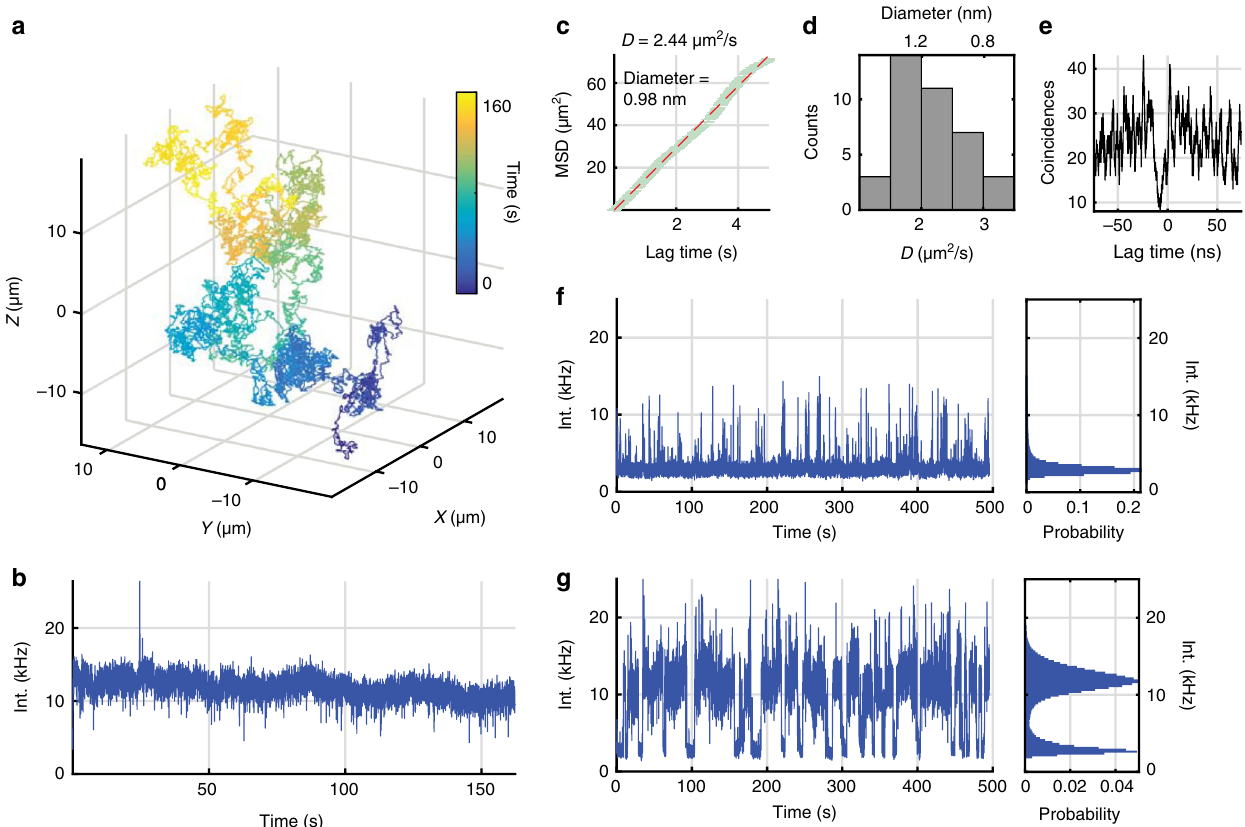
Fig. 2 Locking on to single fl uorophores with 3D-SMART. a 3D trajectory of a single Atto 647 N molecule tracked for 160 s in 90 wt% glycerol. XYZ coordinates are extracted from the readout of the pieozelectric nanopositioner during active feedback. b Intensity trace recorded during the trajectory shown in ( a ), showing uniform intensity despite the rapid diffusion of the molecule. c MSD versus lag time and linear fi t of the trajectory in ( a ), yielding a hydrodynamic diameter of 0.98 nm, consistent with a single fl uorophore. d Histogram of diffusion coef fi cients and hydrodynamic diameters of a population of Atto 647 N trajectories (number of trajectories n = 38). e Photon-pair correlation trace for the molecule in Fig. S6a, showing anti-bunching of photon arrivals at short lag time. f , g Comparison of single-molecule data collection with feedback ( f ) off and ( g ) on. Histograms demonstrate the increase in photon collection with the feedback enabled, as well as the uniform observed emission rate from tracked fl